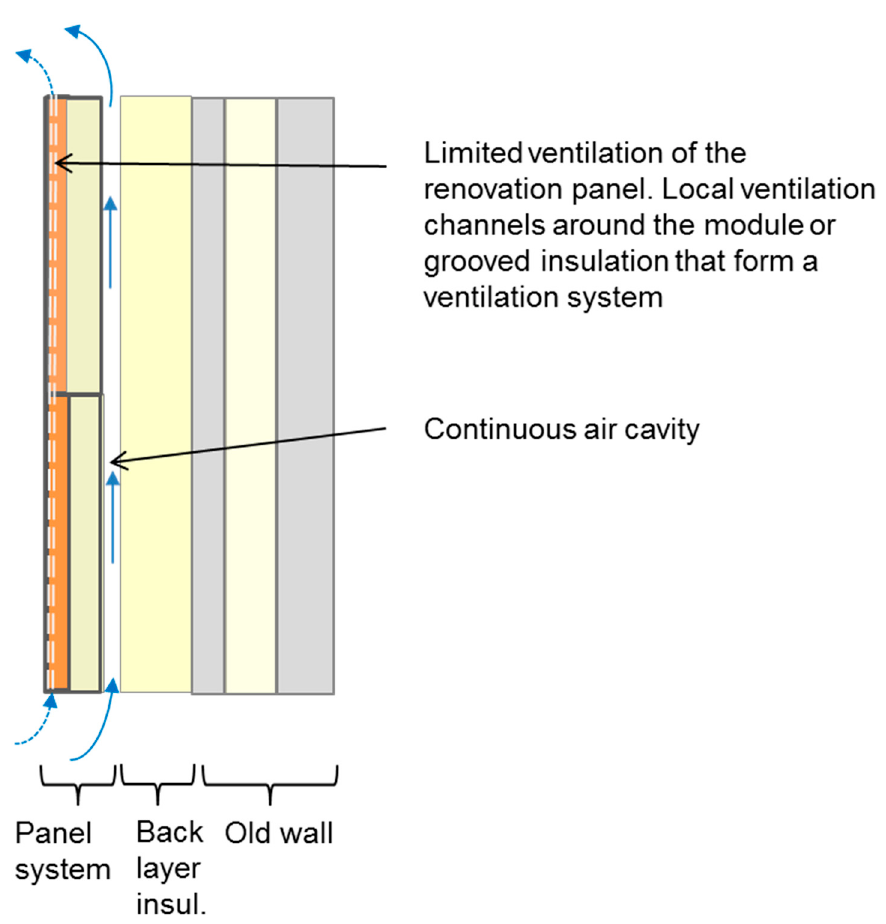
Figure 7. Two possible ventilation schemes of the Meefs renovation module system.